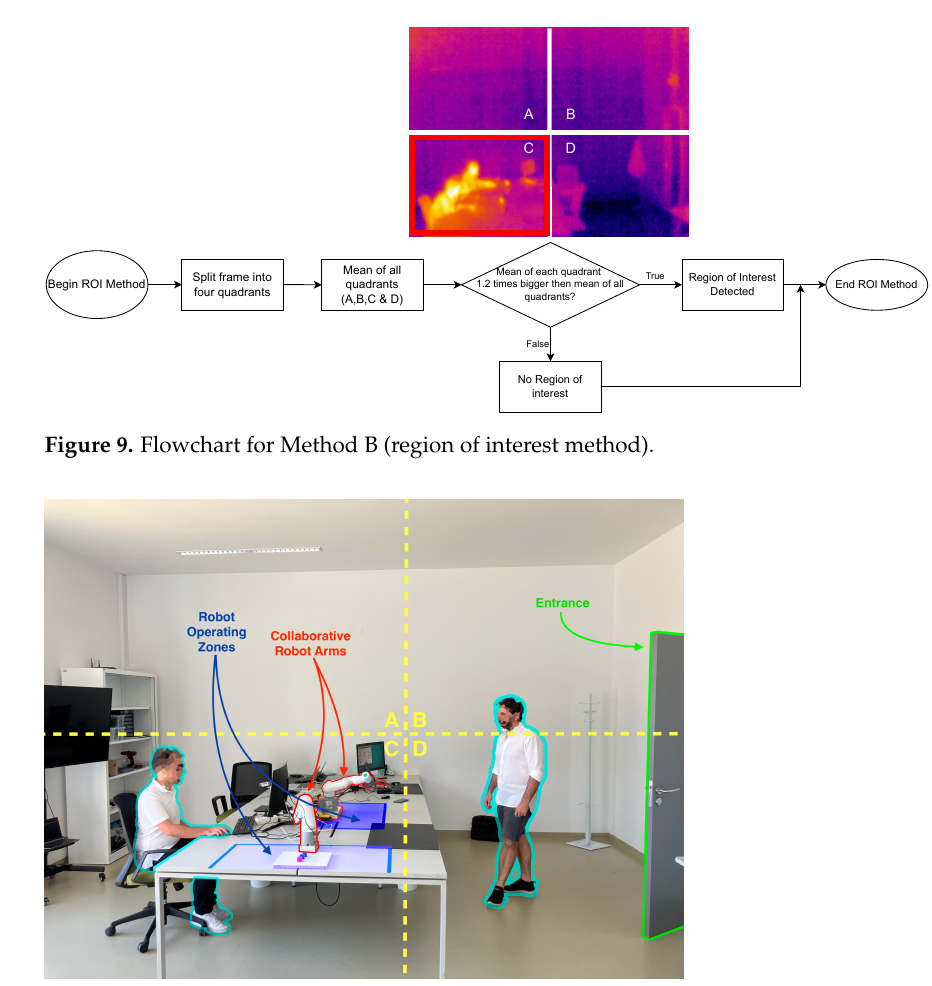
Figure 8. Flowchart for Method A (movement detection approach).